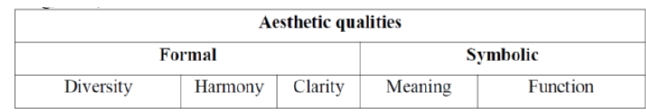
Table 1. Grouping of aesthetic